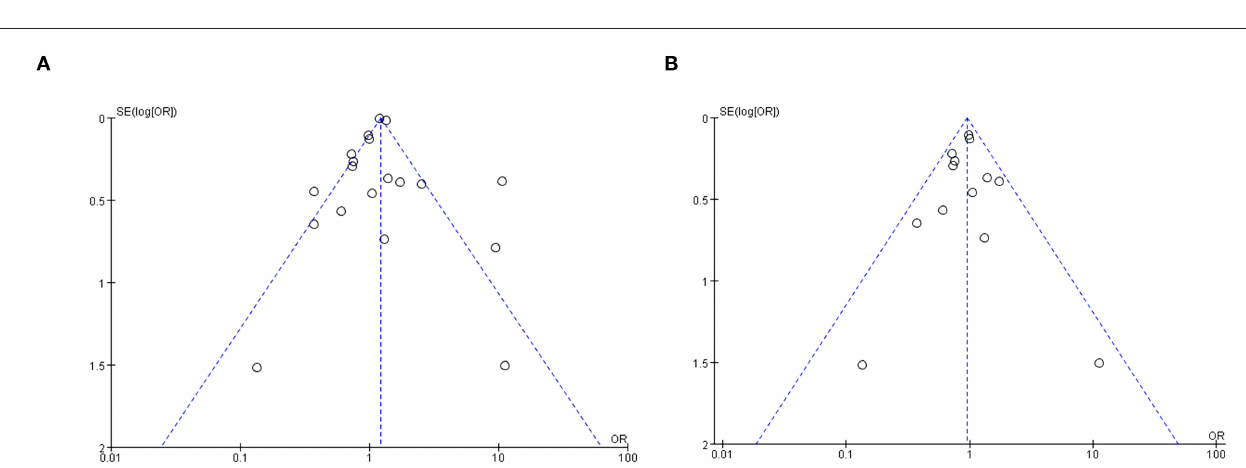
GA and RA (OR = 1.12, 95% CI: [1.00, 1.25], I 2 = 80%, p for effect = 0.05) ( Figure 5 ).